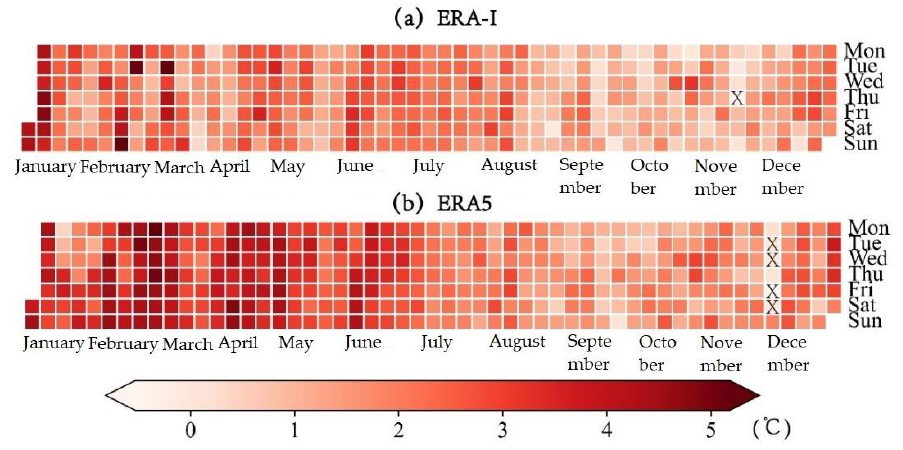
Figure 5. The calendar diagram of the daily Ta biases for ( a ) ERA-I and ( b ) ERA5 based on the multi-year mean. The symbol “X” denotes the days with negative biases.